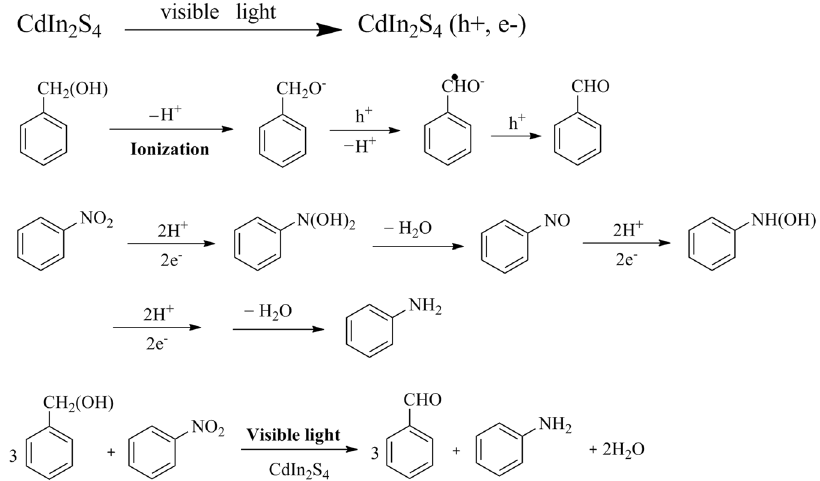
Figure 15. Proposed mechanism for the selective oxidation of benzyl alcohol to benzaldehyde and reduction of nitrobenzene into aniline in a coupled system under visible